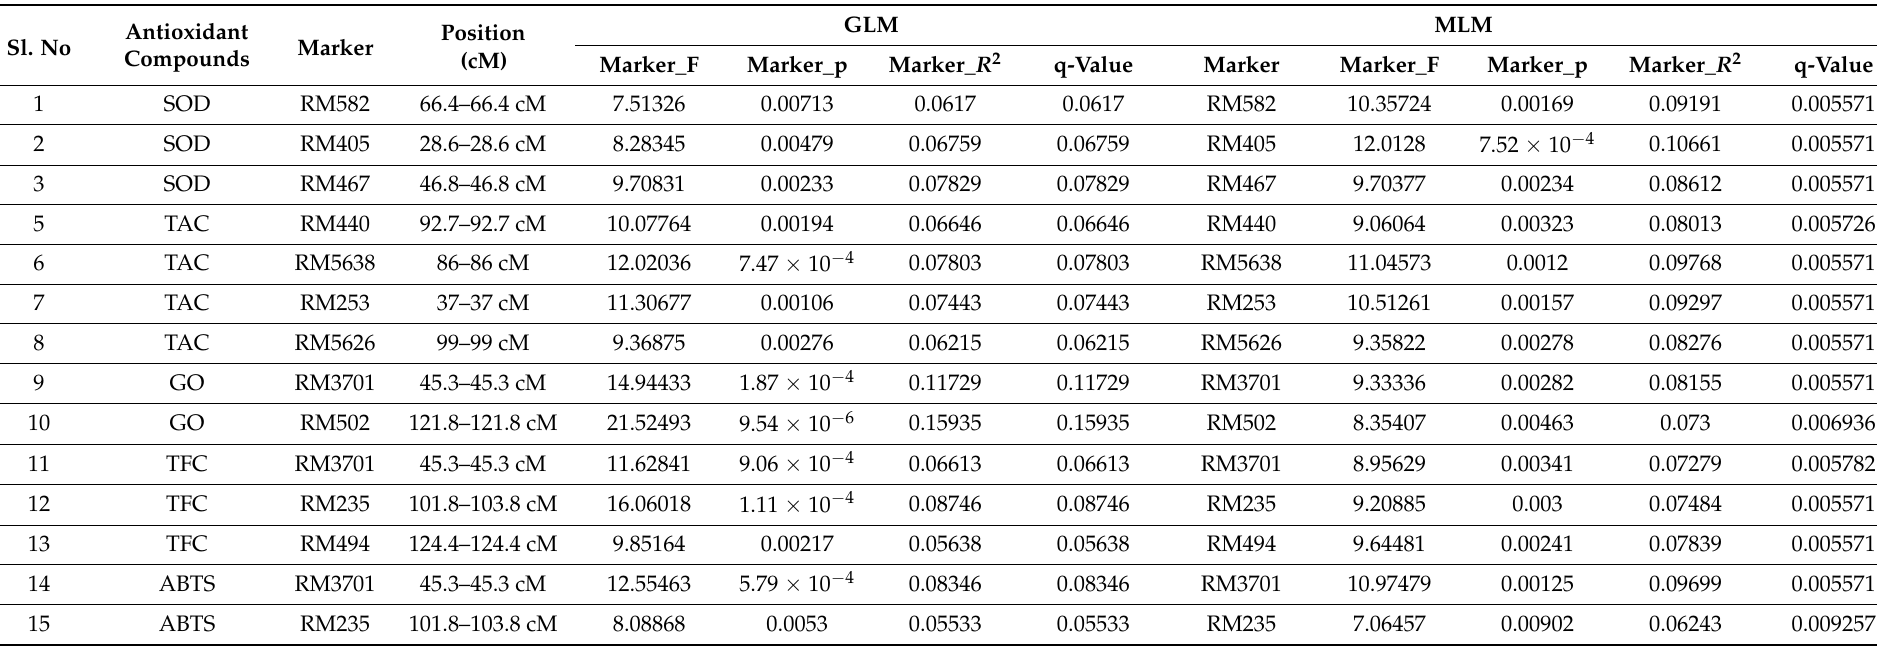
Table 5. Marker–trait associations with antioxidant content in the panel population detected by both the models of GLM and MLM at p <